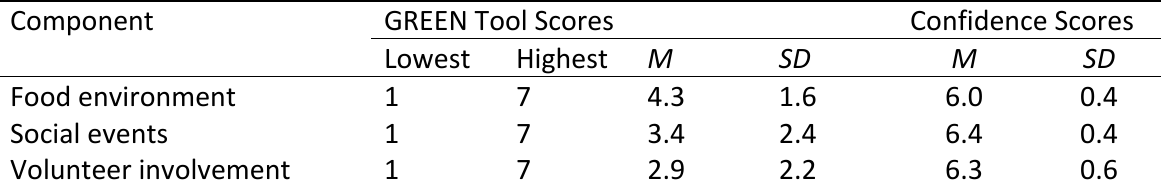
Table 6 Summary and Comparison of GREEN Tool and Confidence Scores for Domain 4 (n = 15)